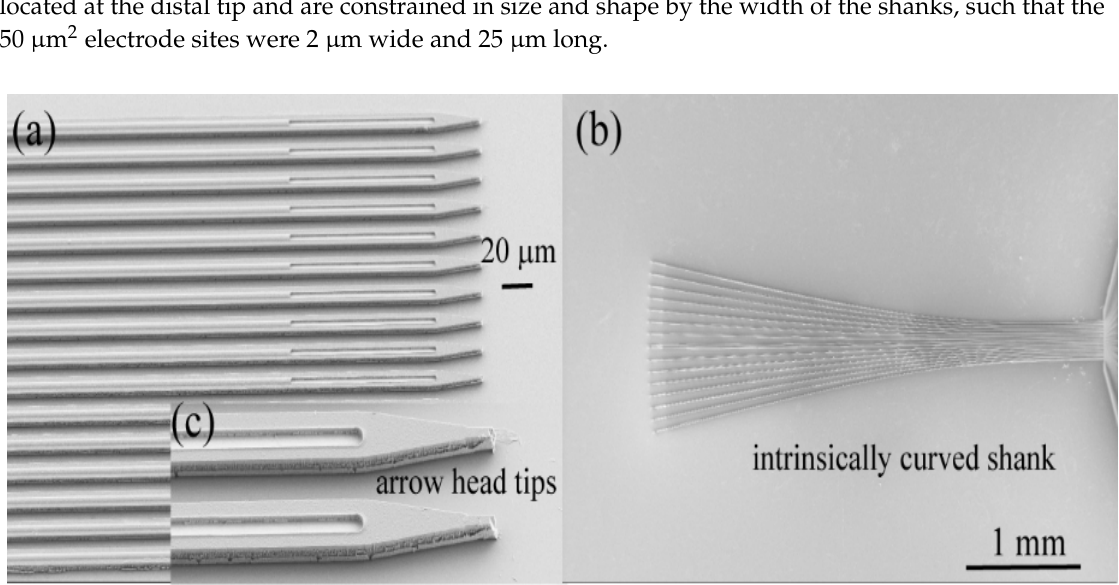
Figure 2. Scanning electron micrographs of as-fabricated 16 channel a-SiC intracortical ultramicroelectrode arrays with straight shanks of identical length ( a ) or intrinsically curve shanks ( b ). Tip profile and electrode site opening are shown in ( c ).